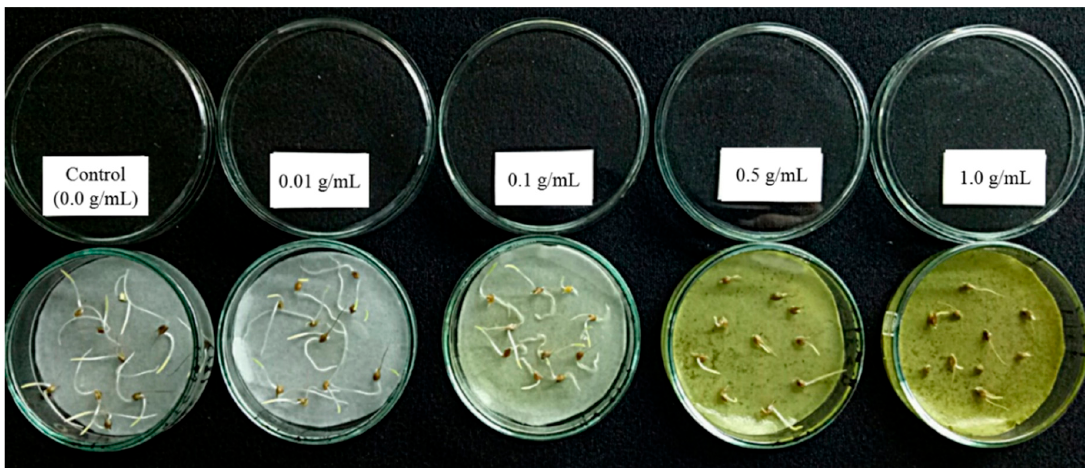
Figure 1. E ff ect of MeOH extracts (0.01, 0.1, 0.5 and 1.0 g · mL − 1 ) from OM5930 rice cultivars on the shoot and root elongation of barnyardgrass ( Echinochloa crus-galli (L.) Beauv) at 48 h after incubation.